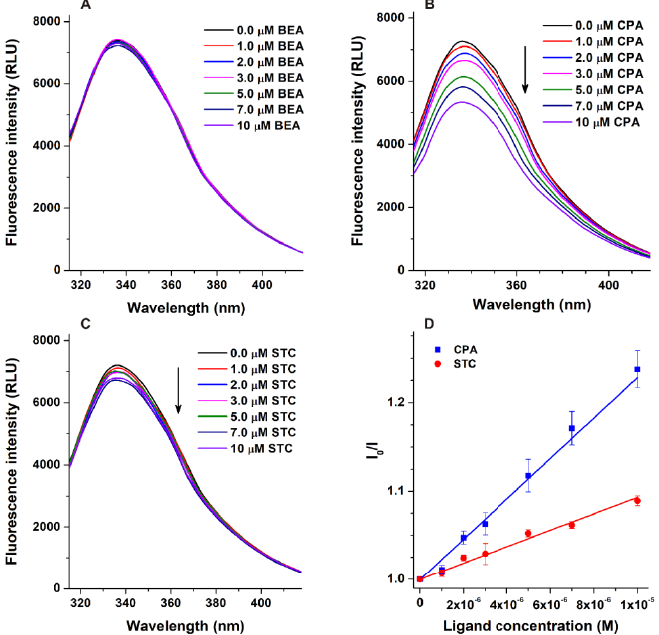
Figure 2. Fluorescence emission spectra of HSA (2.0 μM) in the presence of the increasing concen- trations of BEA ( A ), CPA ( B ), and STC ( C ) in PBS (pH 7.4; λ ex = 295 nm). Stern – Volmer plots of CPA – HSA and STC – HSA complexes ( D ; λ ex = 295 nm, λ em = 340 nm). Table 1. Decimal logarithmic values of Stern – Volmer quenching constants ( K SV ; unit: L/mol) and association constants ( K a ; unit: L/mol) of CPA – HSA and STC – HSA complexes based on spectro- scopic (see details in Section 2.2) and ultracentrifugation (see details in Section 2.4) experiments; and the bound fraction (%) of mycotoxins in the presence of 40 g/L ( ≈600 μM) HSA in PBS (pH 7.4; see experimental details in Section 2.4).